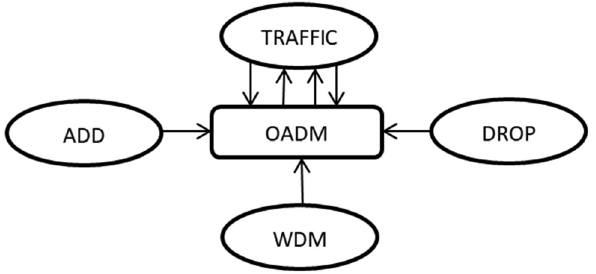
Figure 1: The block diagram of the OADM node.